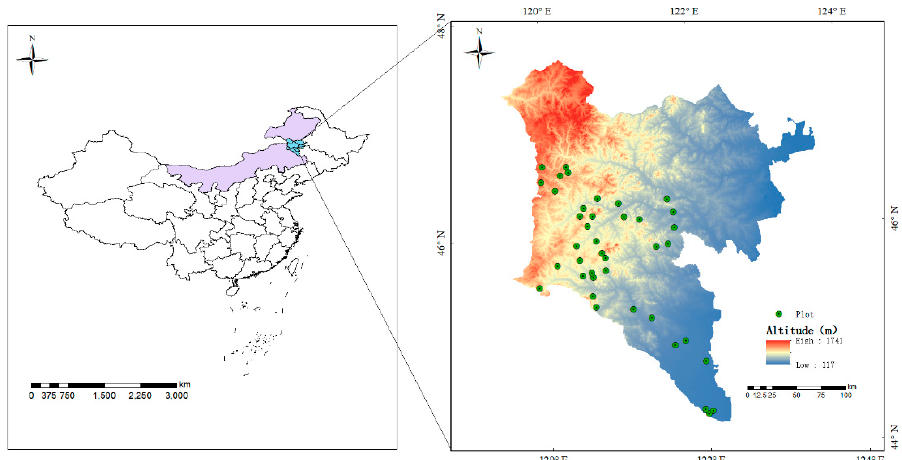
Figure 1. The distribution map of shrub plots in the forest-grass transition area of Inner Mongolia.